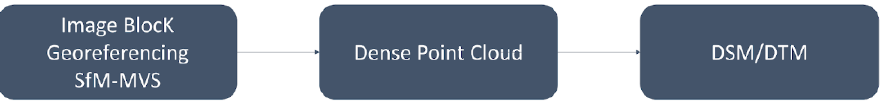
Figure 6. Photogrammetric workflow.